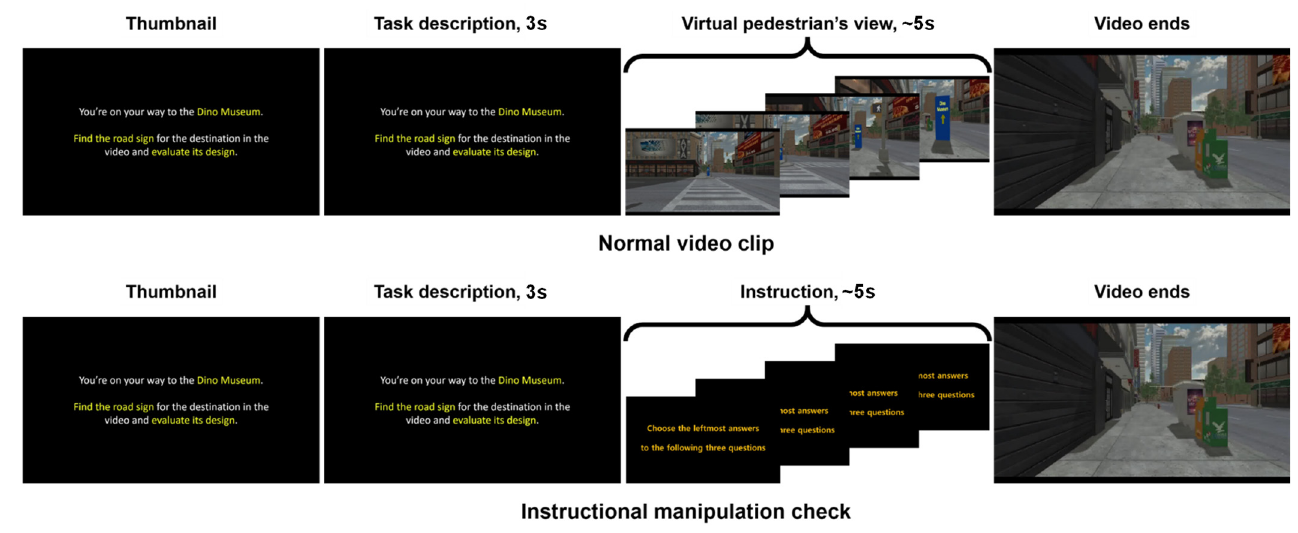
Figure 9. Video clips used for crowd design evaluation (upper: normal video clip; lower: instructed question). The main portion of the instructional manipulation check was intended to identify malicious or inattentive participants.